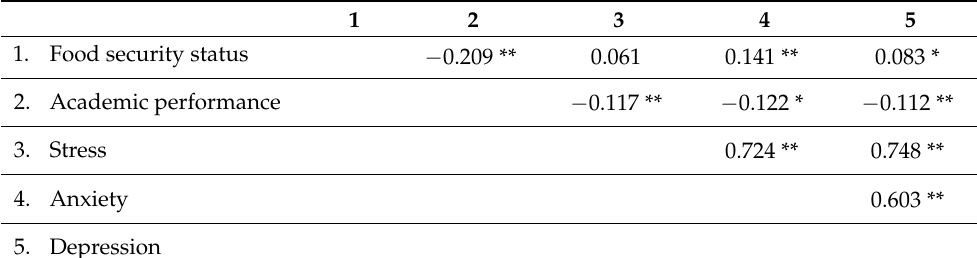
Table 2. Correlation between food security status associated with stress, anxiety, and depression.